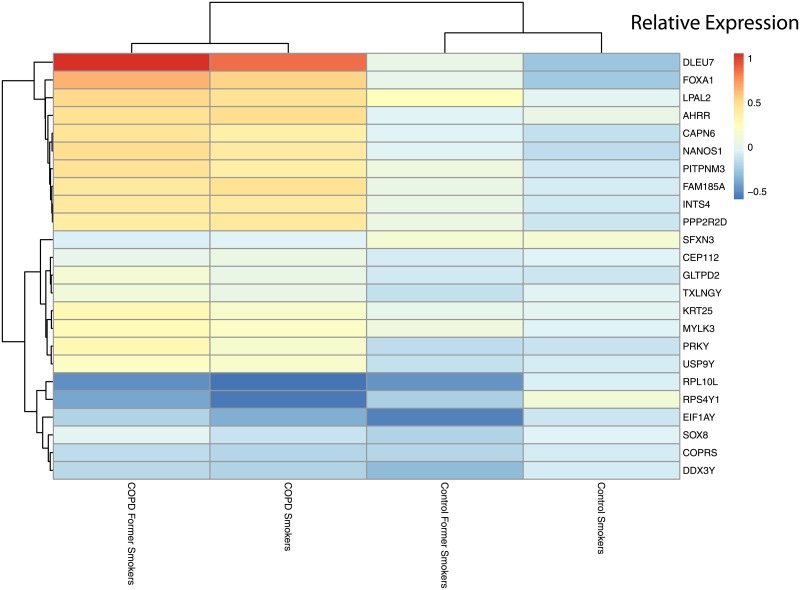
Heatmap of statistically significant interacting genes across disease states and smoking statuses.Relative expression calculated using control non-smokers as the baseline.